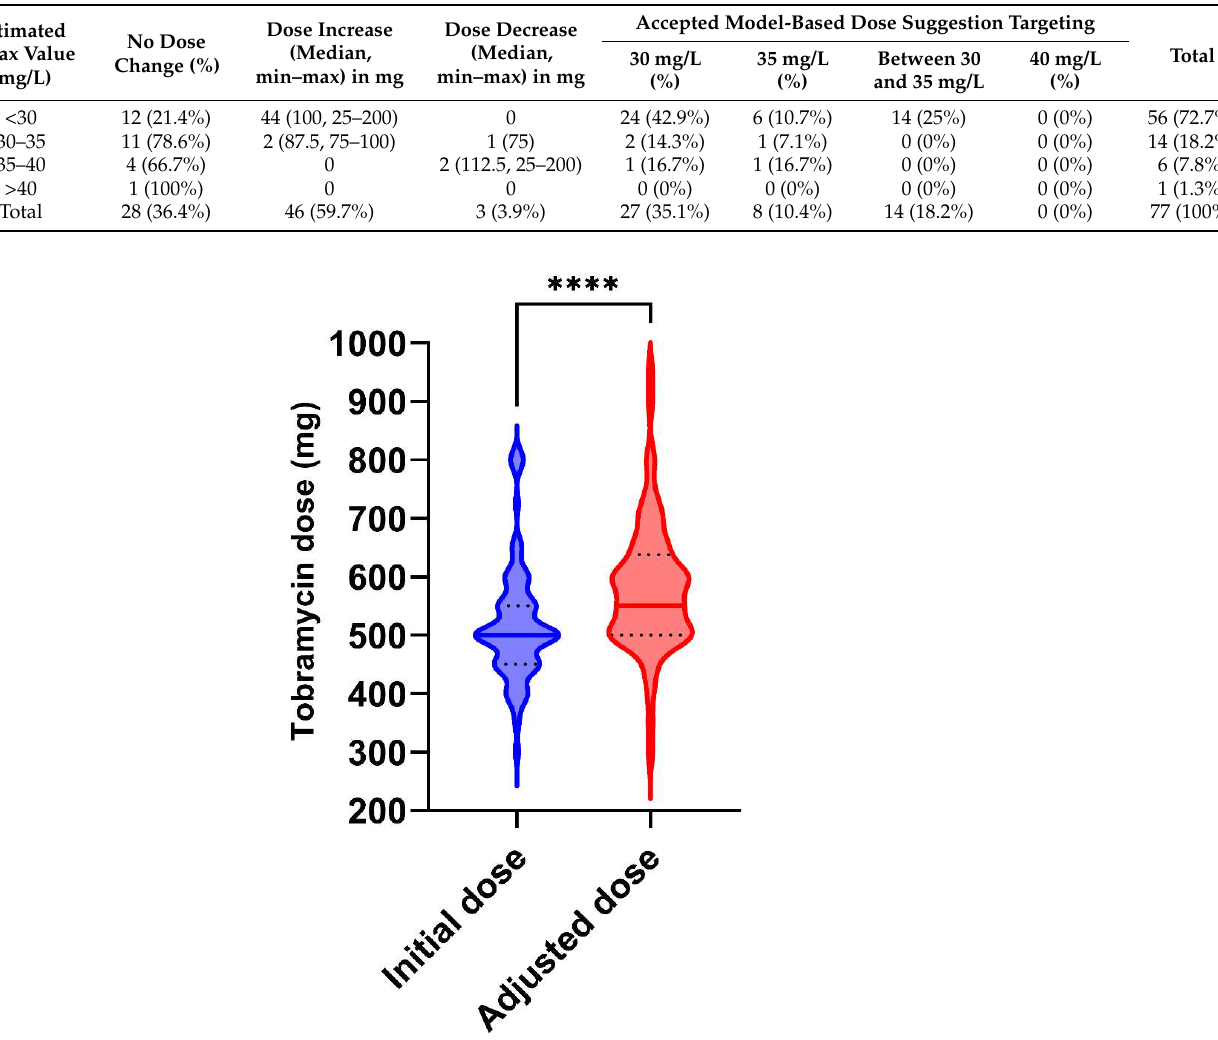
Figure 3. Violin plots of tobramycin doses before and after dose adjustment. The central solid line is the median. The black dotted lines are the quartiles (25th and 75th percentiles). Symbol **** indicates p < 0.0001.